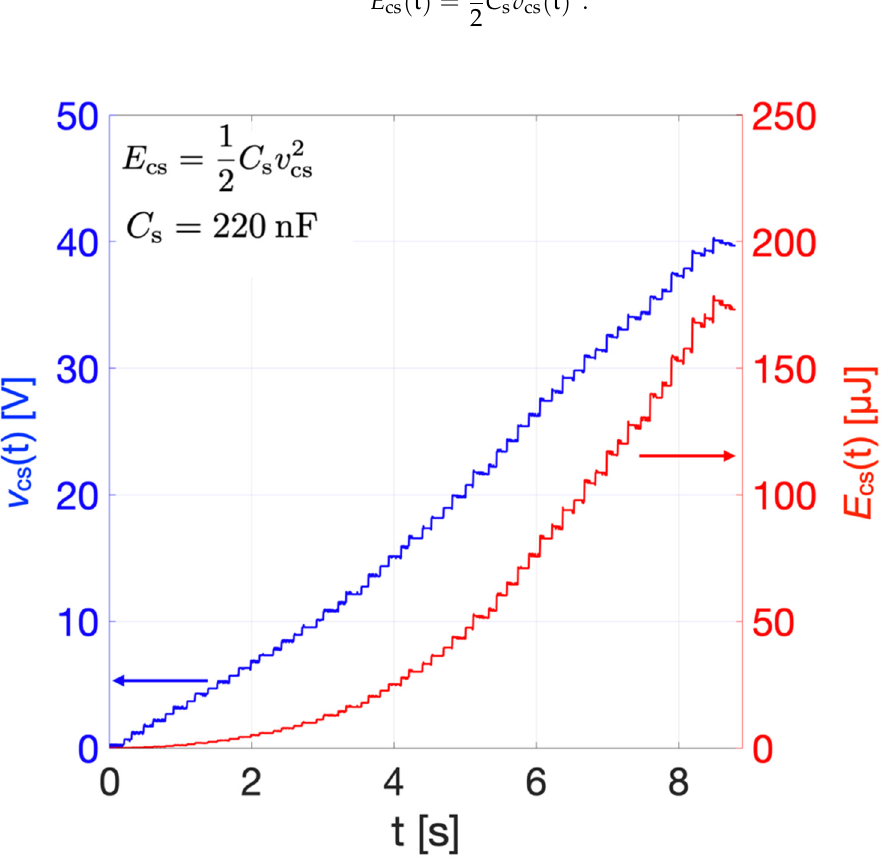
Figure 13. Measured rectified voltage v cs (t) (blue curve) and estimated energy E cs (red curve) stored in capacitor C s , induced by multiple consecutive impacts.